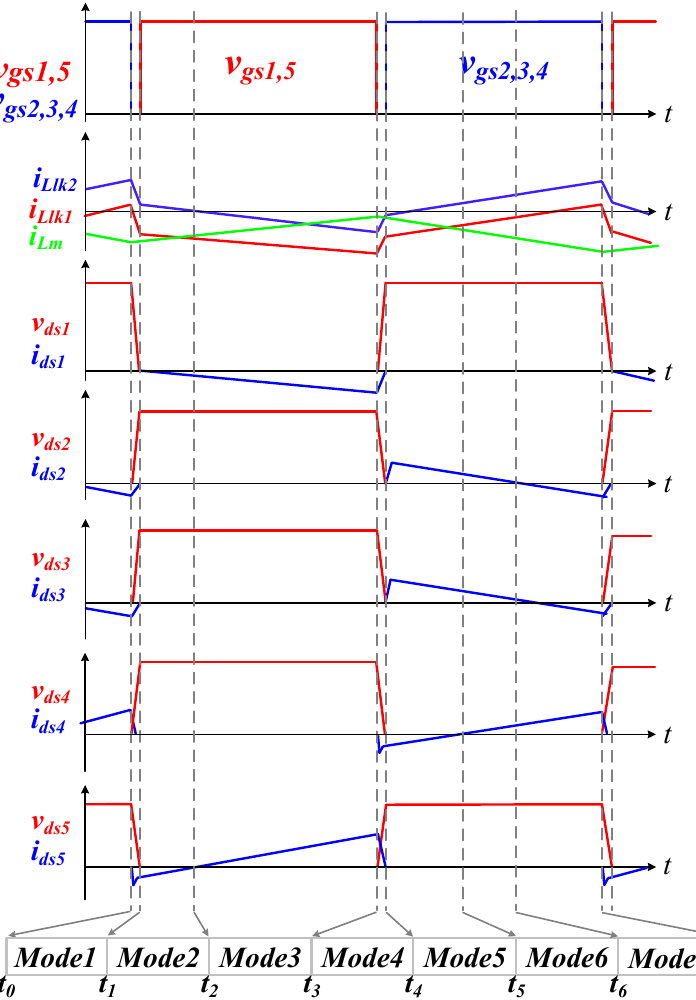
Figure 5. Key waveforms of the proposed topology in the step-down mode.